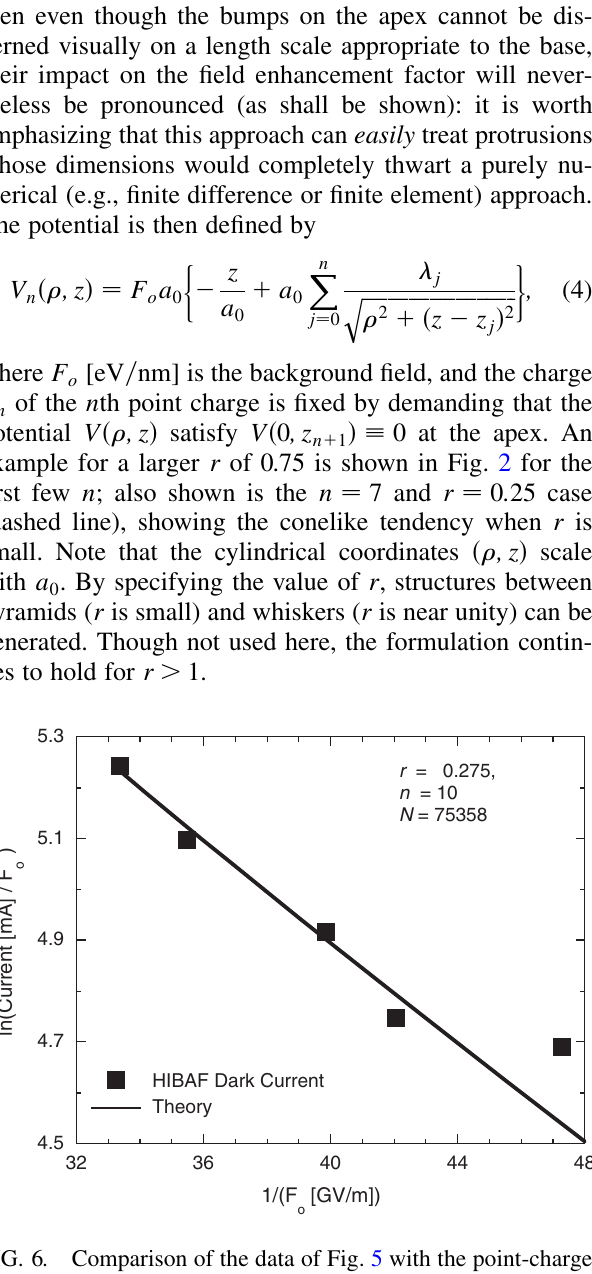
FIG. 6. Comparison of the data of Fig. 5 with the point-charge model coupled with a semiconductor field emission model to estimate of the factors r , n , and N for the origins of field emission on the CsK Sb photocathode surface in the Los 2 Alamos high-brightness accelerator FEL